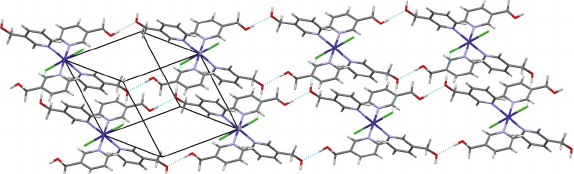
Figure 5. A perpendicular view of a two dimensional layer of hydrogen-bonded CoCl